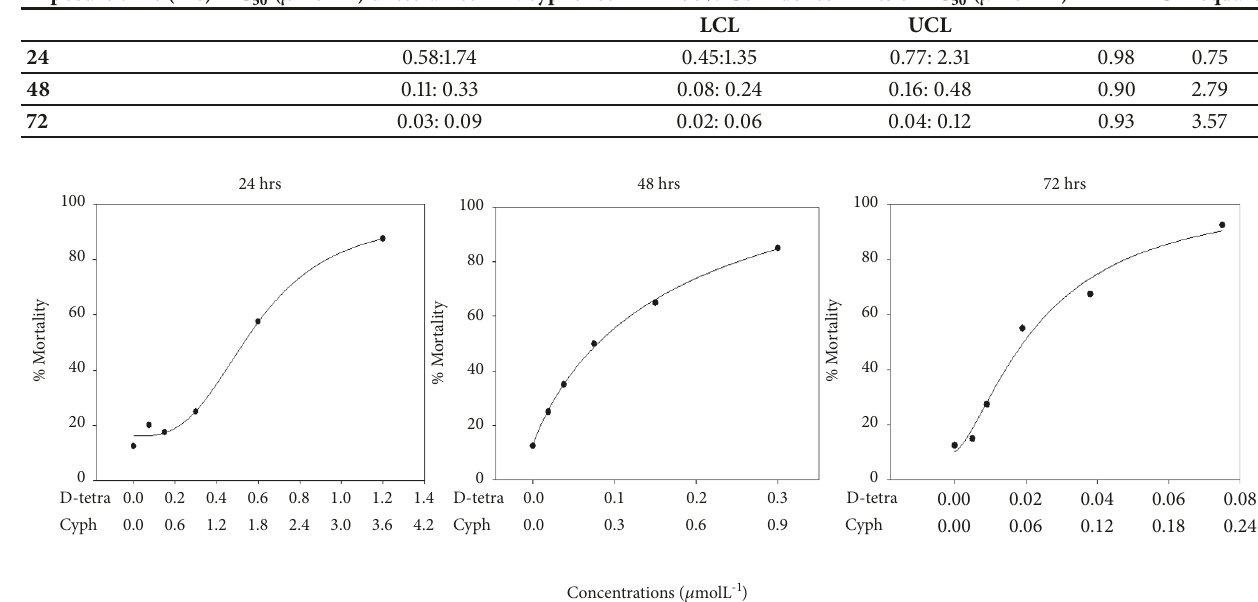
Figure 1: Graphical representation of % mortality of zebrafish embryos against different concentrations at 24, 48, and 72 hour time intervals. The curves were fitted into 4-parameteric sigmoidal hill curve using SigmaPlot 14 software. Mean values of percentage mortality of two different experiments were plotted against concentrations. 0% is minimum value and 100% is maximum